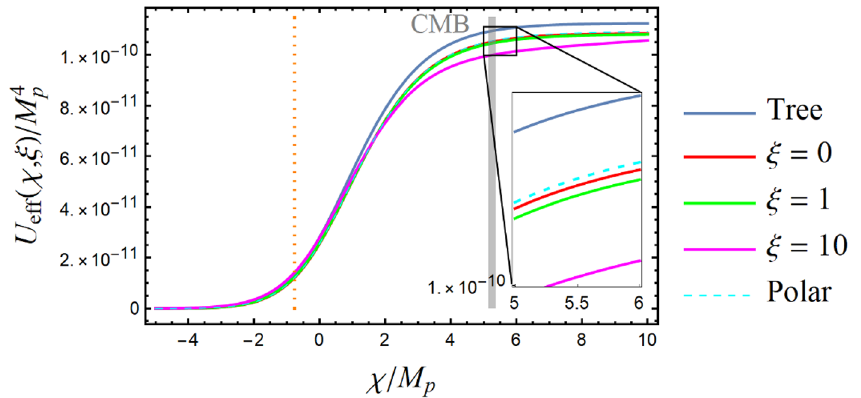
Figure 6 . The shape of the final potential U eff ( χ, ξ ) for different choices of ξ in Cartesian coor- dinates (solid lines) and the polar one (dashed line). The parameters are chosen to be the same as in figure 1, namely λ = 0 . 13 , e = 0 . 3 , m = 0 , α = 17000 , µ/M p = 0 . 049 . The CMB scale with 50 . N CMB . 60 corresponds to the field range 5 . 1 . χ/M p . 5 . 4 , and is indicated by the gray band. The dotted orange line represents the end of inflation defined by the exit condition (cid:15) = O (1)